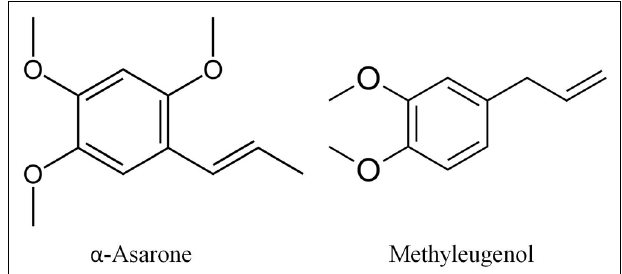
FIGURE 1 | Chemical structure of α -asarone and methyleugenol (4-allyl-1,2-dimethoxybenzene).